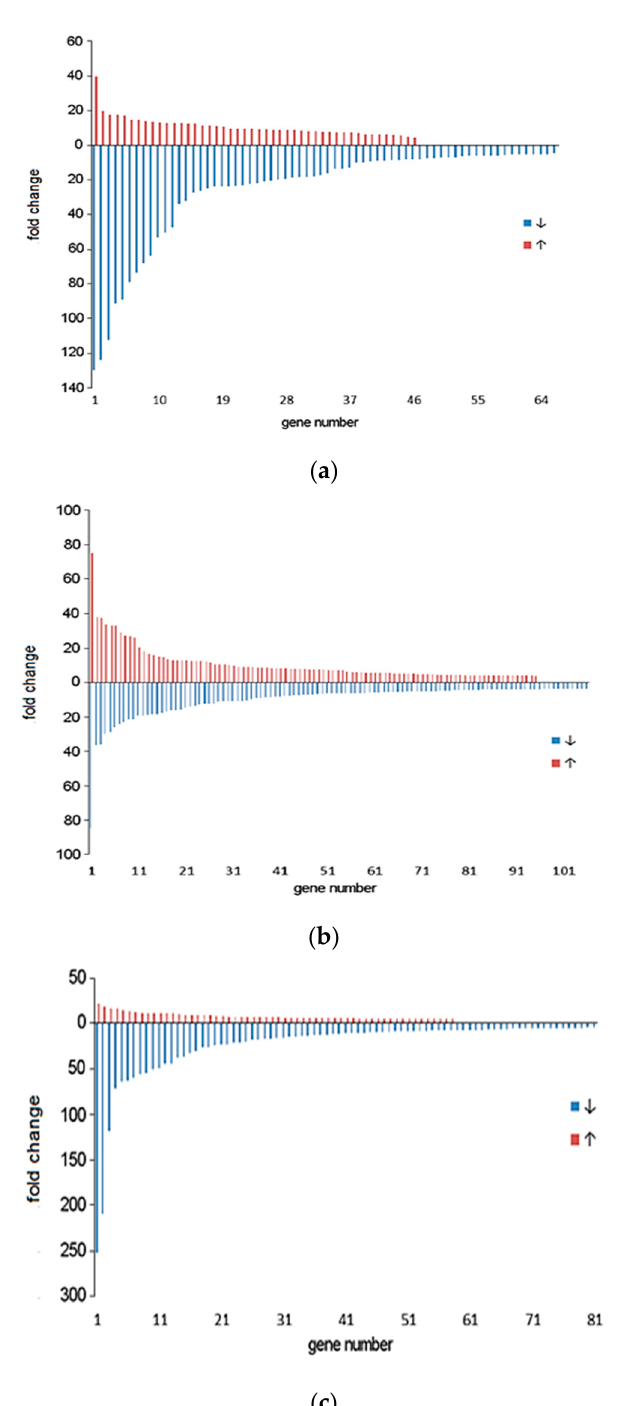
Figure 6. Distribution of fold changes in gene expression resulting from nitrogen limitation during cultivation of Pseudo ‐ monas putida KT2440 wild type ( a ) and relA/spoT ( b ) and rpoN mutants ( c ) (blue, downregulated; red, upregulated). The graph shows genes with statistically significant differences in expression.